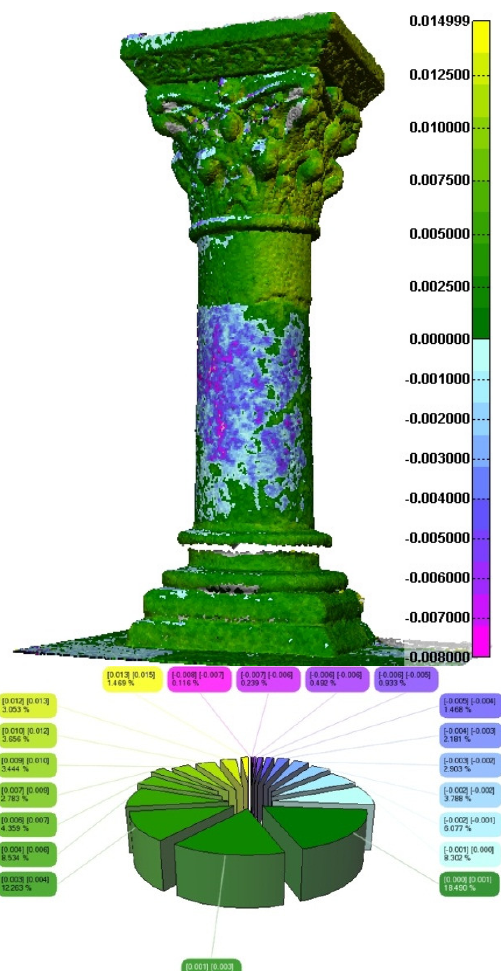
Figure 8. Error-map color mode and pie-type error distribution chart for subproject 4.